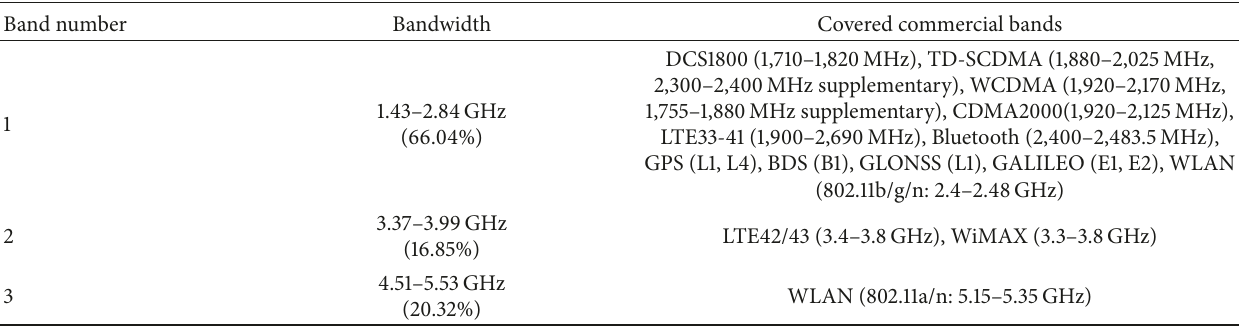
Table 2: Frequency bands covered by the